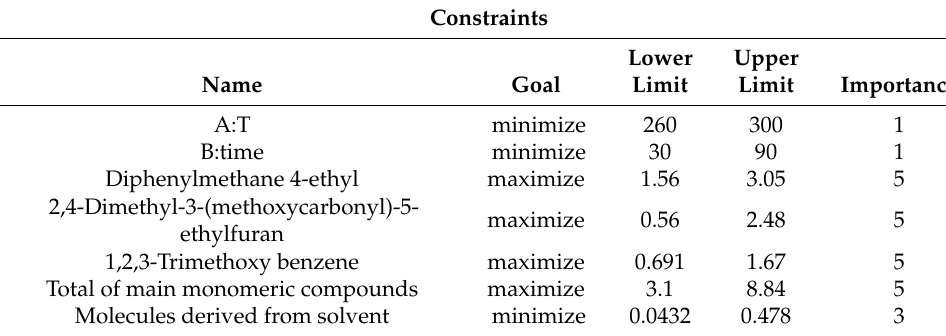
Table 2. Criteria used for reaction parameter optimization.